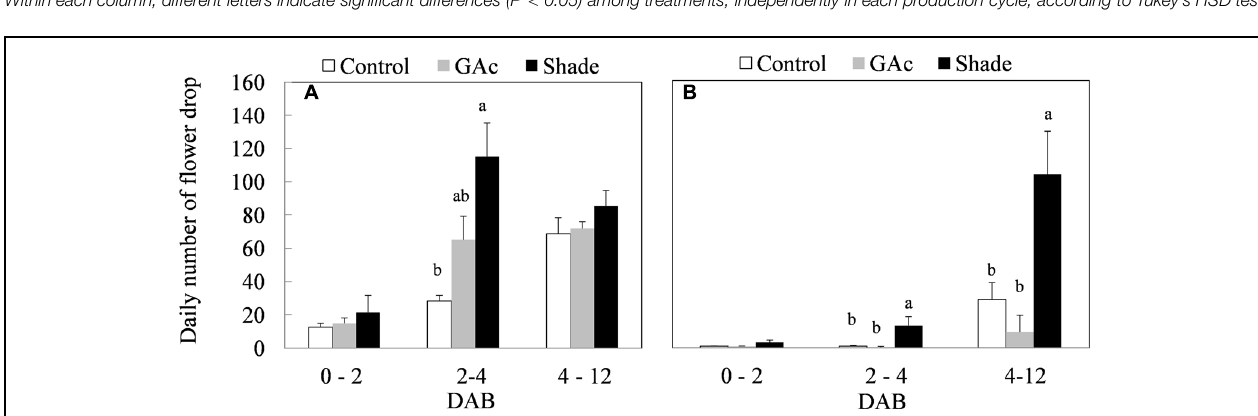
Frontiers in Plant Science |